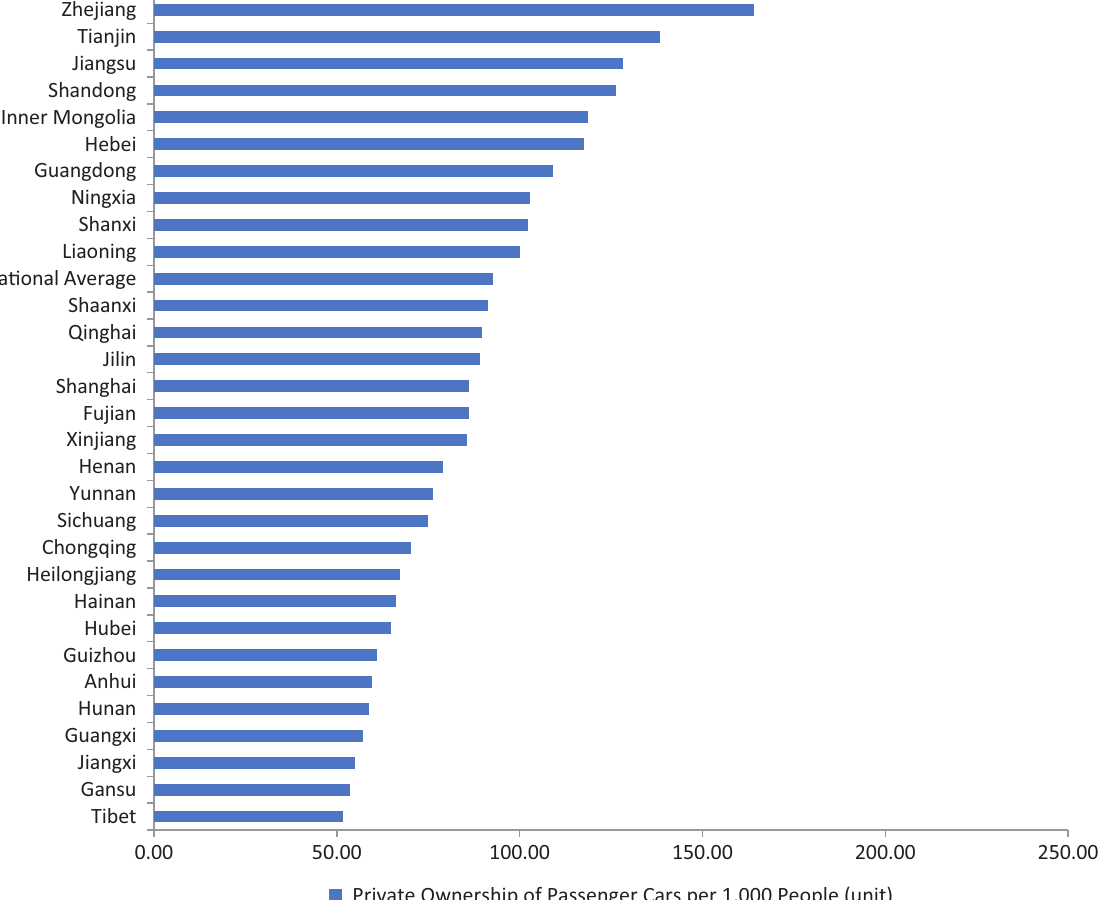
Figure 1. Private ownership of passenger cars per 1,000 people across China in 2015 (unit). Source: Compiled based on data provided by the National Bureau of Statistics of the People’s Republic of China (NBSC,